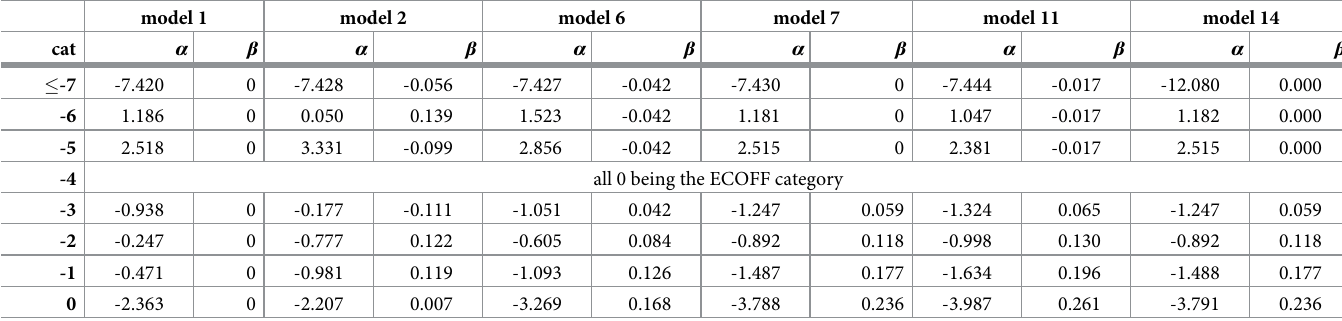
Table 3. The CIPR data: Estimates of intercepts and slopes of model 1, 2, 6, 7, 11 and